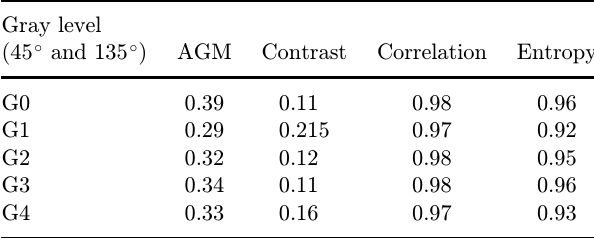
Table 2. The texture features at angles 45 (cid:1) and 135 (cid:1)